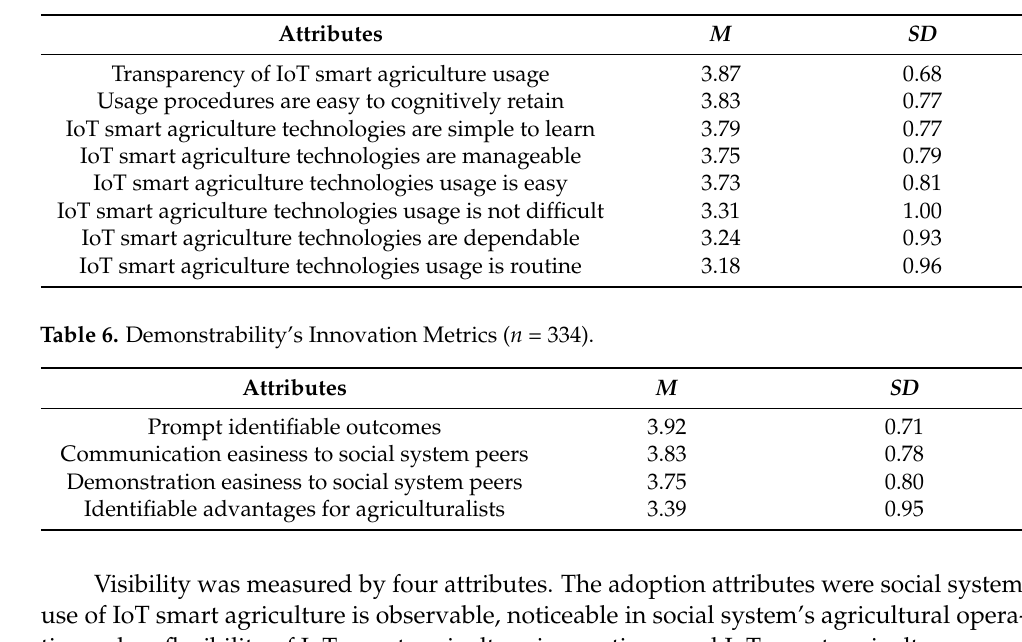
Table 5. Ease of Use’s Innovation Metrics ( n = 334).